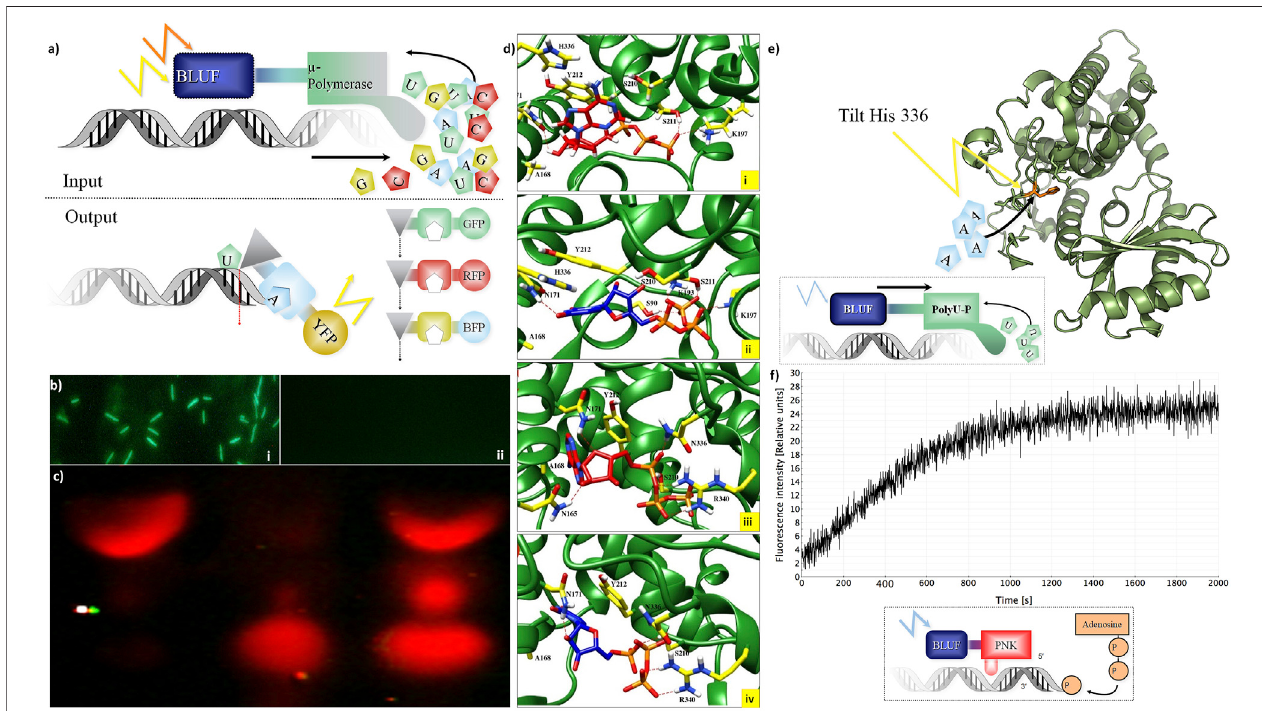
FIGURE 2 | Integration of DNA storage for easy read-in and read-out. (A) Concept of light-gated protein. Input (top): μ -DNA polymerase is used to achieve light- gated(BLUFdomainfusedto μ -DNApolymeraseconstructsforeachnucleotide)andtemplate-freeDNAsynthesis.Outputconstructs ( bottom):light-gatedexonuclease constructs(triangles)arefusedtospeci fi cnucleotide-bindingdomains(squares)andtriggerdifferent fl uorescentproteinsforread-out. (B) Light-gatedproteinexpression in vivo. BLUF – GFPconstruct transfected bybacteriawithdifferentexpressionsofGFP with(Panel (i) )and without (Panel (ii) ) presence ofblue light. (C) Light-gated exonuclease activity: fi rst line: positive control (only cyanine-5 – labeled hexamer loaded on gel), second line: BLUF – exonuclease activity in the dark, third line: BLUF – exonuclease activity withthepresenceofblue light. (D) Modeling: ATP(red) and UTP(blue) at bindingsite oftheCid1polymerase.Panel (i) : docking ofATPinthe wt Cid1 binding pocket. Panel (ii) depicted the UTP-Cid1 for the docking to the binding pocket of the wt Cid1 (PDB: 4FH5). In panel (iii) (ATP-Cid1 complex) and (iv) (UTP-Cid1complex), the complexes areshown forthe case ofthe H336N mutation (PDB:4FHX). Thehistidine 336does not form any hydrogen bonds with theligands, whereas N336 is involved in H-bond formation with ATP. Residues S211 and K197 from the binding cavity of the wt. of Cid 1 polymerase (H336) are participating in hydrogen bond formation with ATP, CTP, GTP and UTP. K193 participates in hydrogen bond formation with all triphosphates, except ATP. In the latter N336 and R340 play roles in H-bond formations with ATP, GTP and UTP. N171 forms H-bonds with ATP, CTP, and UTP, but it does not form H-bond with GTP. Moreover, the numberofresidualcontactsfortheATPaswellasfortheUTPdockedtothebindingcavityofH336Npolymeraseishighercompared totheATPandUTPdockedtothe native structure. We may assume that mutation of H to asparagine at position 336 could in fl uence the binding mode of ATP as well as UTP. Key amino acid residue composition inside the binding site involved in hydrogen bond formations are highlighted in yellow. Red dashed lines indicate the H-bonds. (E) Histidine tilting of PolyU polymerase(structuremodeling).Top:ahistidineinthePolyUpolymerasedomain(PDB fi leshown:4FH3)determinesifATPorUTPwillbeacceptedfortheelongationof the RNA strand. The histidine 336 could be tilted by light to achieve rapid changes in substrate speci fi city according to user-speci fi ed sequences of ATP and UTP. (F) T4Polynucleotidekinase asanexampleofDNA-processingenzyme.Light-controlledphosphate transfermeasurement:assayforT4kinaseDNAelongation constructs usingprocessed fl uorescentoligonucleotidesformonitoringtheiractivity;constructcalculationstopredictjoinedcooperativechangesafter(Leeetal.,2008;Halabietal., 2009). Bottom: a sketch of the light-gated protein construct. A BLUF domain (BLUF, blue) is directed by light (blue fl ash) and stops or activates the T4 polynucleotide kinase (PNK, red) which then transfers a phosphate group from ATP to the end of a polynucleotide ( example: DNA, shown in grey